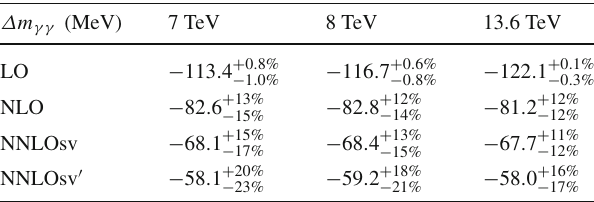
Table 2 Mass-shift at different proton-proton collider energies with first moment